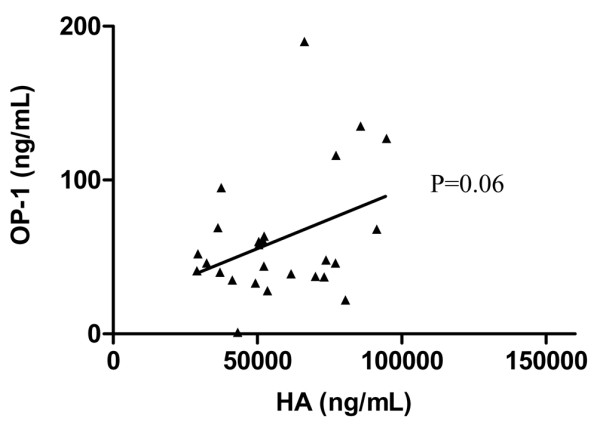
Correlation between osteogenic protein 1 and hyaluronan levels in synovial fluid samples from osteoarthritis patients. In the osteoarthritis group, there is a tendency for a positive correlation between synovial fluid osteogenic protein 1 (OP-1) and hyaluronan (HA) contents (r2 = 0.1345, P = 0.0654).